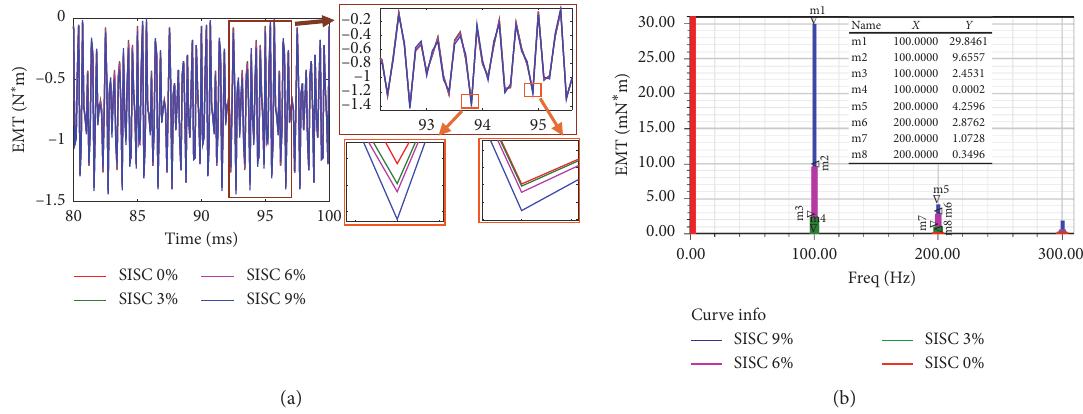
Figure 9: EMT under SISC fault. (a) Time-domain waveform. (b) Spectrum of EMT in different SISC degrees.